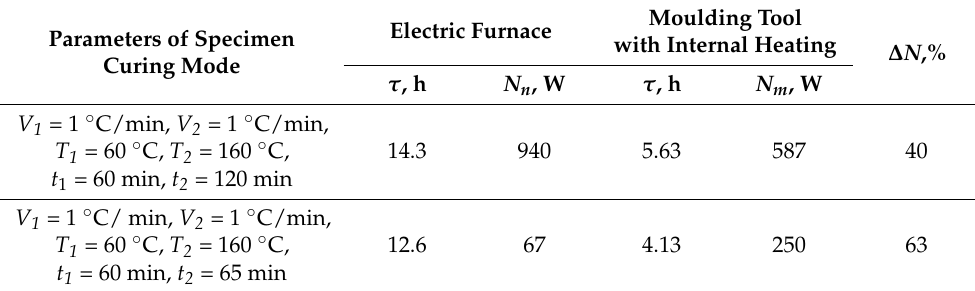
Table 5. Comparison of energy consumption of traditional and new